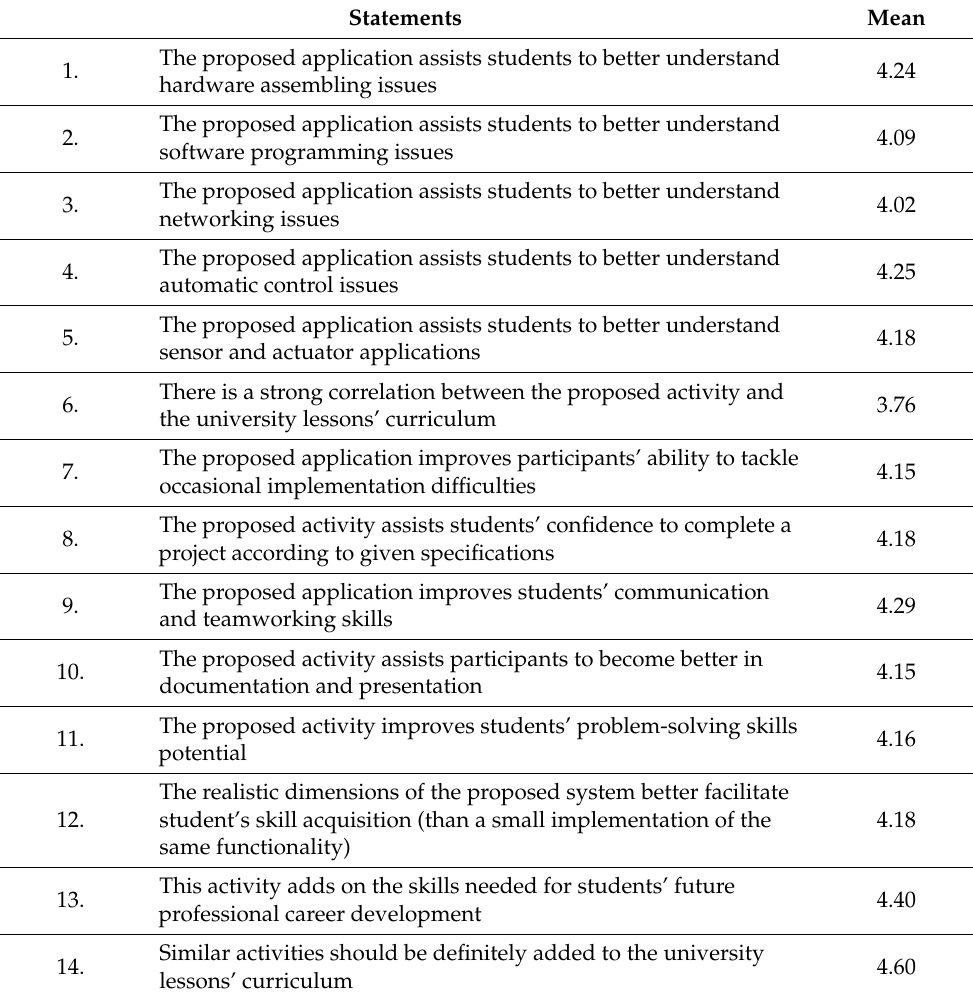
Table A1. Statements used in the evaluation form to measure participants’